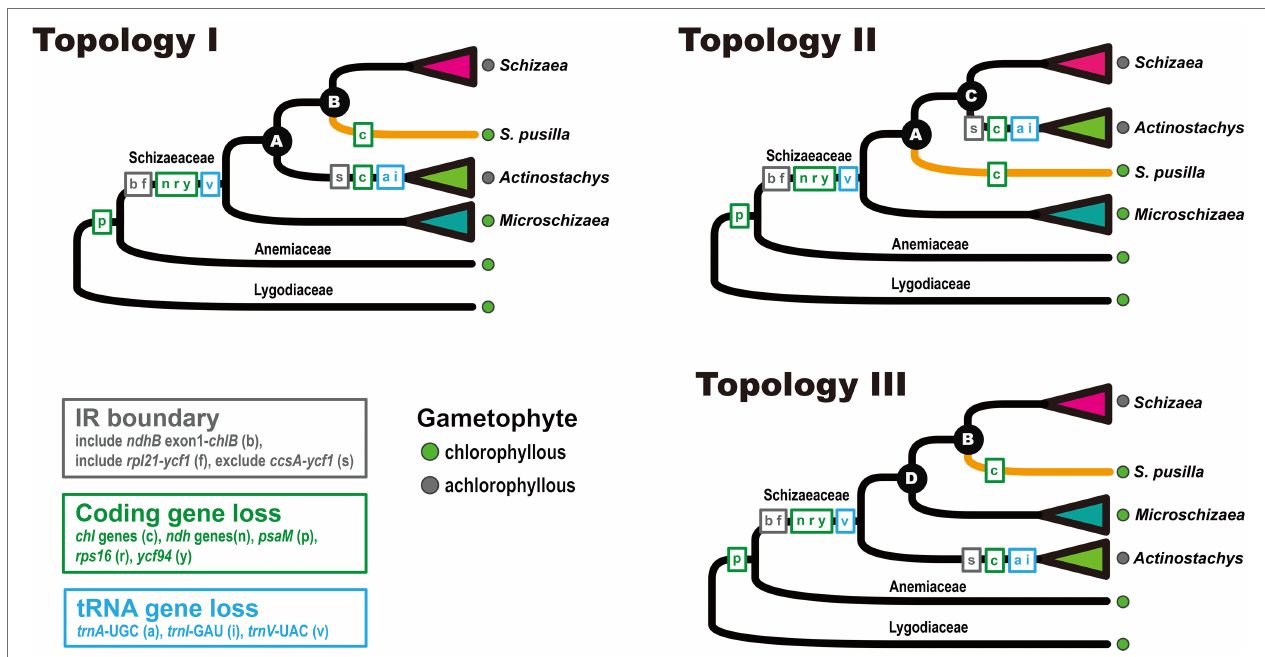
FIGURE 2 | Plastome structural evolution in Schizaeaceae. The three topologies were derived from the phyloplastomic analyses that included different data matrices, models, and